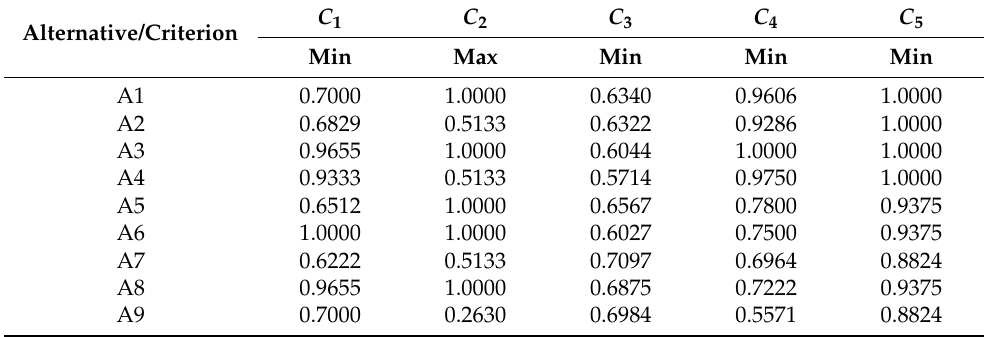
Table 10. Normalized decision